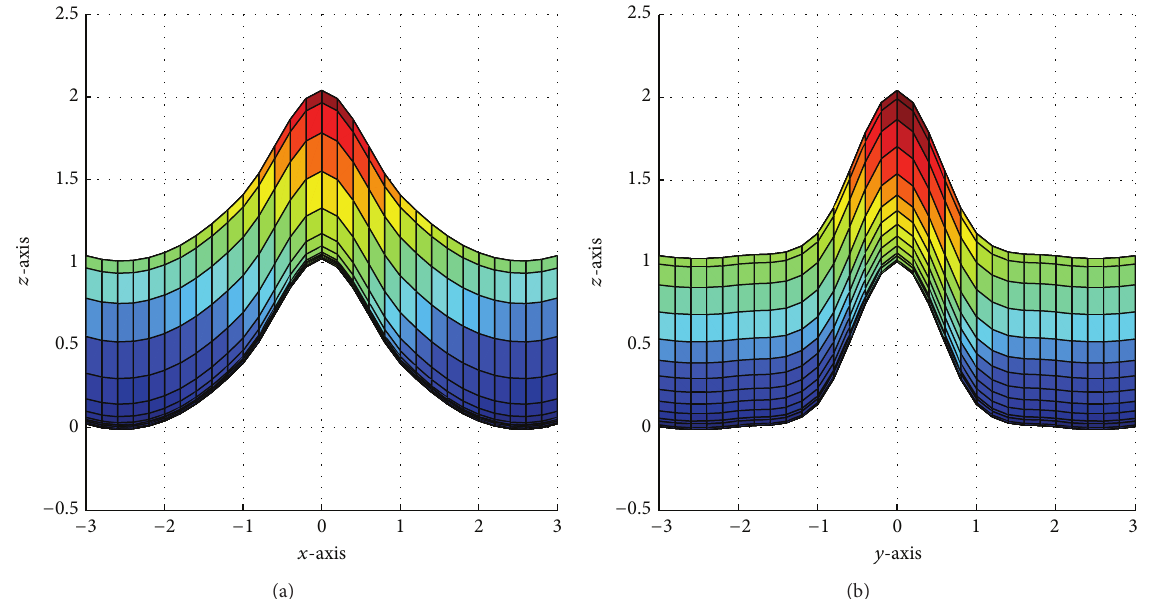
Figure 11: Bicubic Hermite surface: (a) 𝑥𝑧 -view and (b) 𝑦𝑧 -view for Figure 10, respectively.